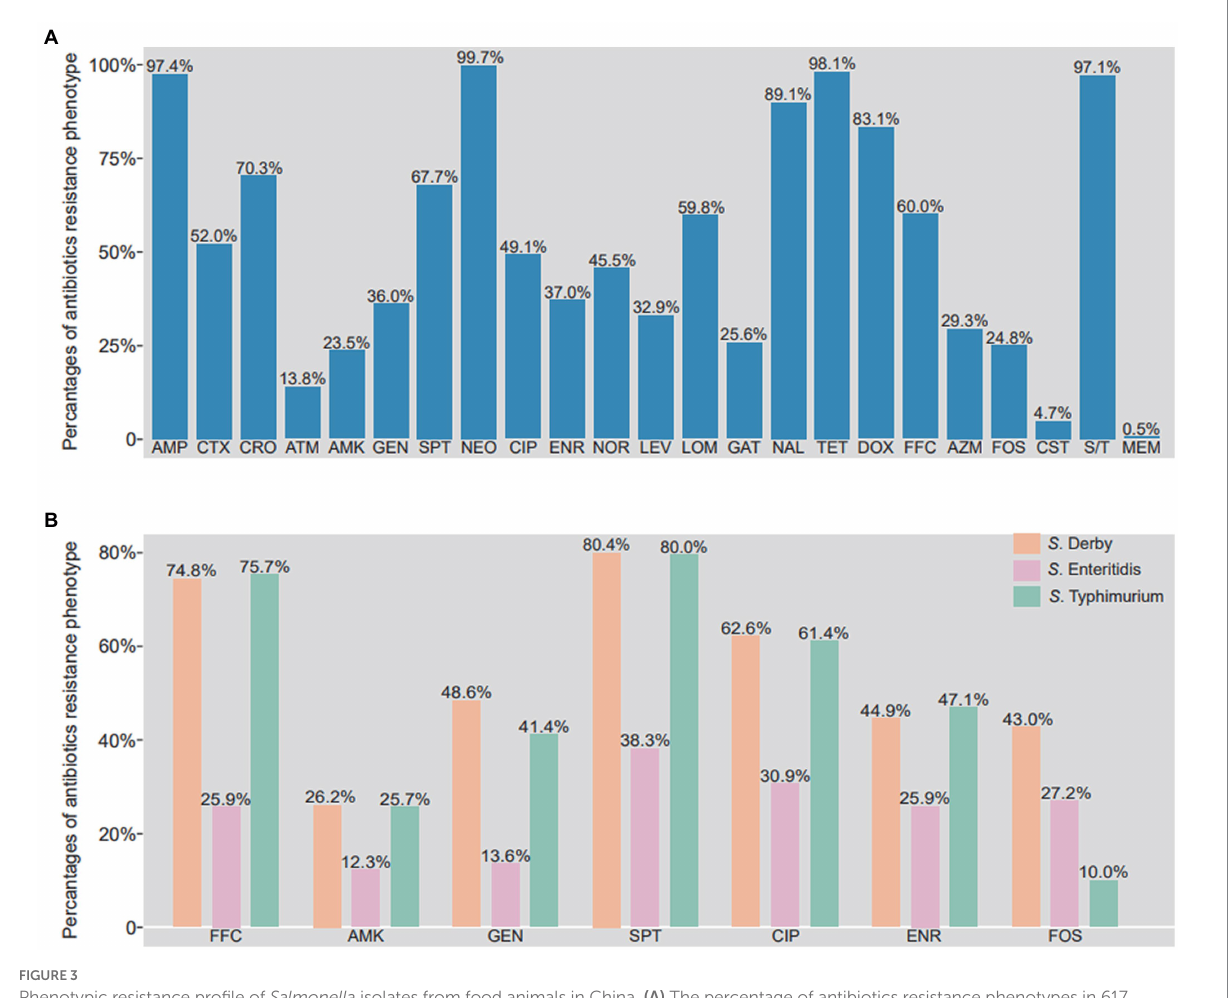
FIGURE 3 Phenotypic resistance profile of Salmonella isolates from food animals in China. (A) The percentage of antibiotics resistance phenotypes in 617 Salmonella isolates. (B) The different of antibiotics resistance phenotypes between S . Derby, S . Enteritidis and S . Typhimurium. AMP, ampicillin; CTX, cefotaxime; CRO, ceftriaxone; ATM, aztreonam; AMK, amikacin; GEN, gentamicin; SPT, spectinomycin; NEO, neomycin; CIP, ciprofloxacin; ENR, enrofloxacin; NOR, norfloxacin; LEV, levofloxacin; LOM, lomefloxacin; GAT, gatifloxacin; NAL, nalidixic acid; TET, tetracycline; DOX, doxycycline; FFC, florfenicol; AZM, azithromycin; FOS, phosphonomycin; CS, colistin; MEM, meropenem; S/T,